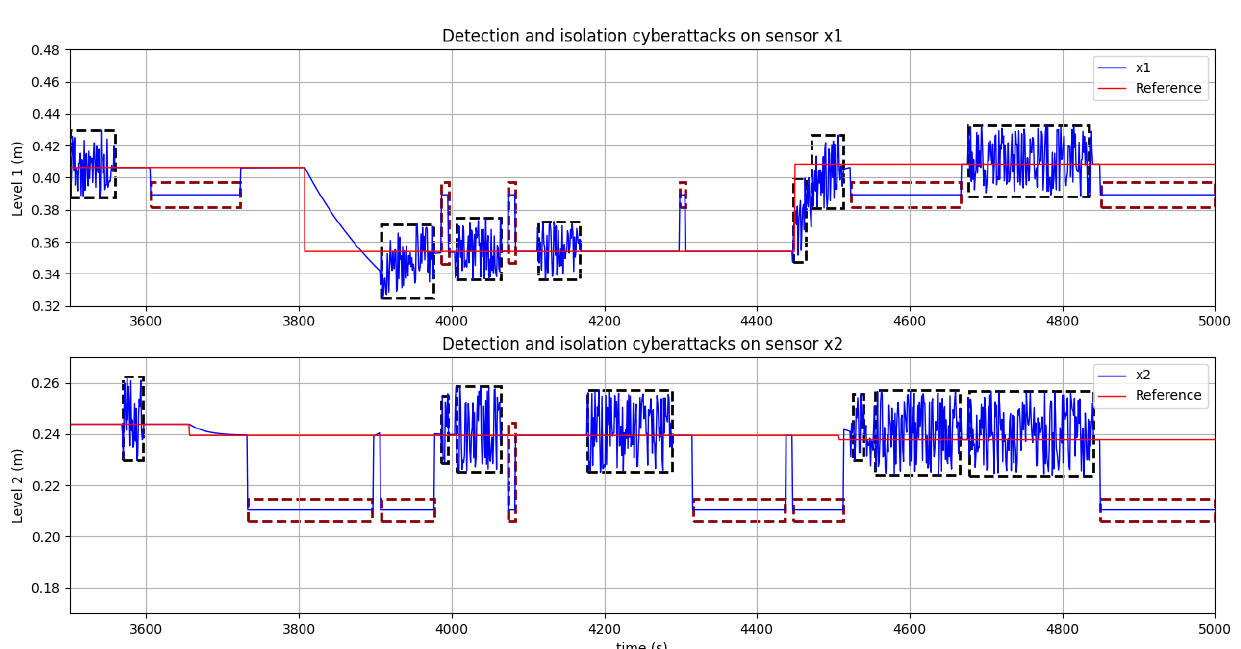
Figure 19. Temporal